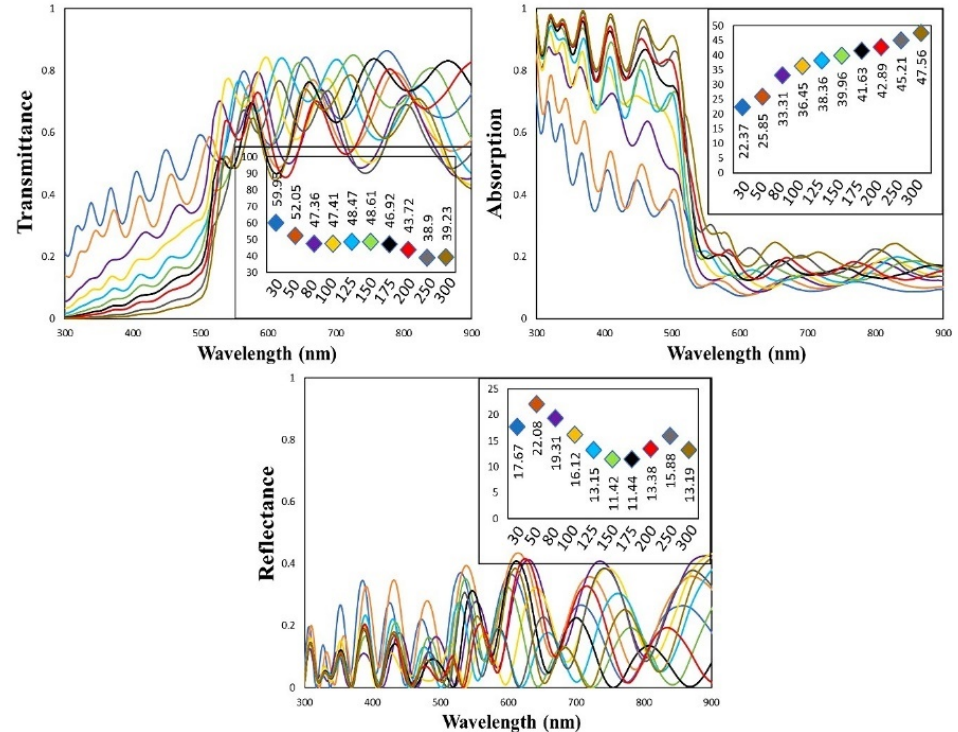
Figure 8. Optical parameters using OPAL2 for CdS (thickness variation)/ITO (200 nm)/UTG.